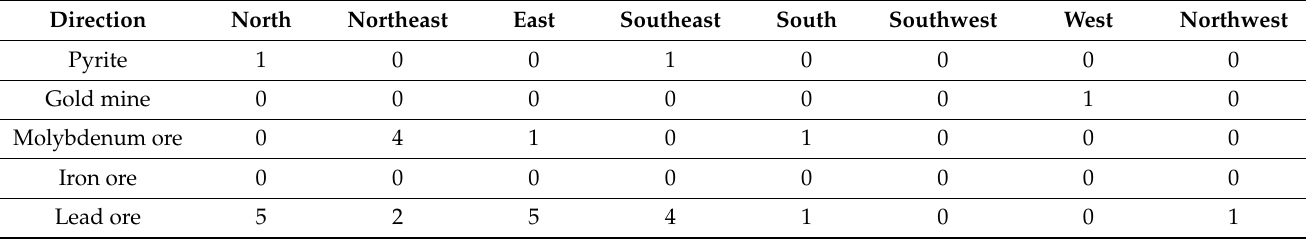
Table 6. Statistics of the eight-center latitude ore points and the mean values of MSEEI